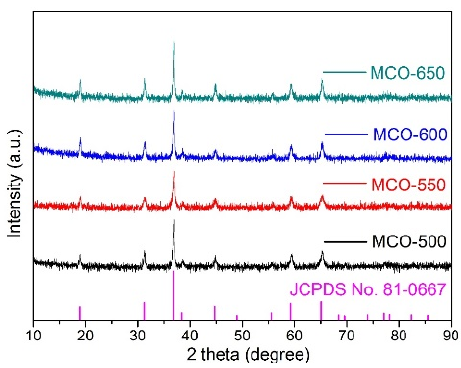
Figure 1. X-ray diffraction (XRD) patterns of MCO-500, MCO-550, MCO-600 and MCO-650.